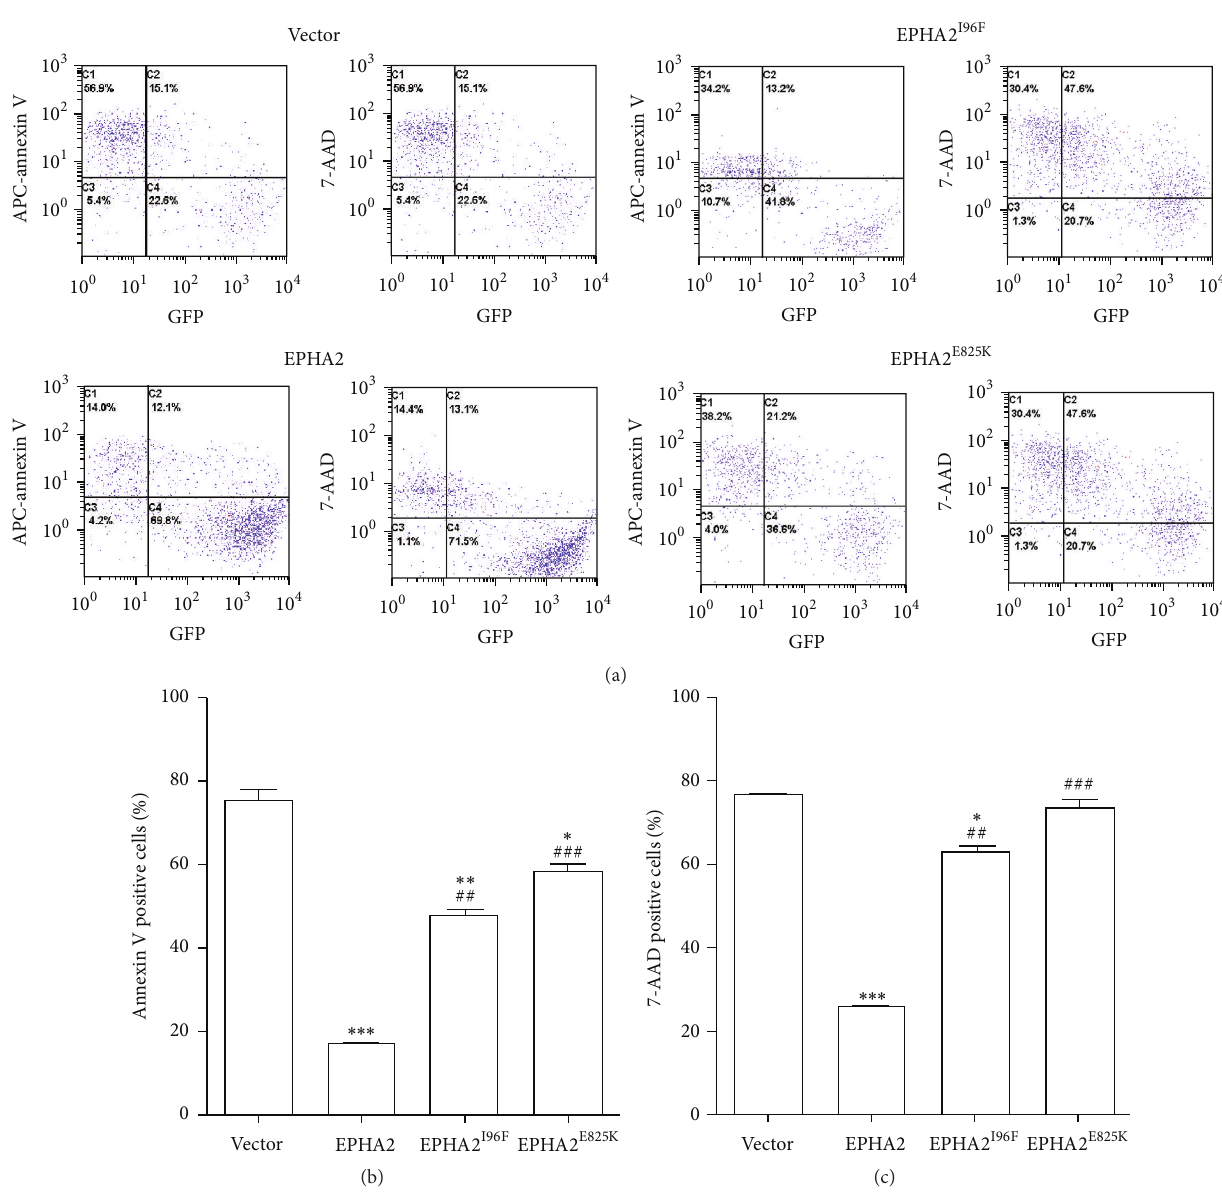
Figure 4: Compromised antiapoptotic function in cataract-associated genetic mutants. (a) After lentiviral infection to introduce control vector, EPHA2, EPHA 2 I 96 F , or EPHA 2 E 825 K into the cells and the administration with 200 𝜇 M H 2 O 2 , the HLECs were digested, dissociated, and stained with either APC-annexin V or 7-AAD, followed by the fluorescence activated cell sorting to analyze the early and late apoptosis. The GFP signal intensity was compromised if the HLECs undergo oxidative stress-induced apoptosis. (b-c) The statistical analysis shows that overexpression of wild-type EPHA2 reduces the proportion of both early and late apoptotic cells. The missense mutations abolish the antiapoptotic effect against oxidative damage. ∗ 𝑝 < 0.05 , ∗∗ 𝑝 < 0.01 , and ∗∗∗ 𝑝 < 0.001 versus vector control; ## 𝑝 < 0.01 , ### 𝑝 < 0.001 versus wild-type